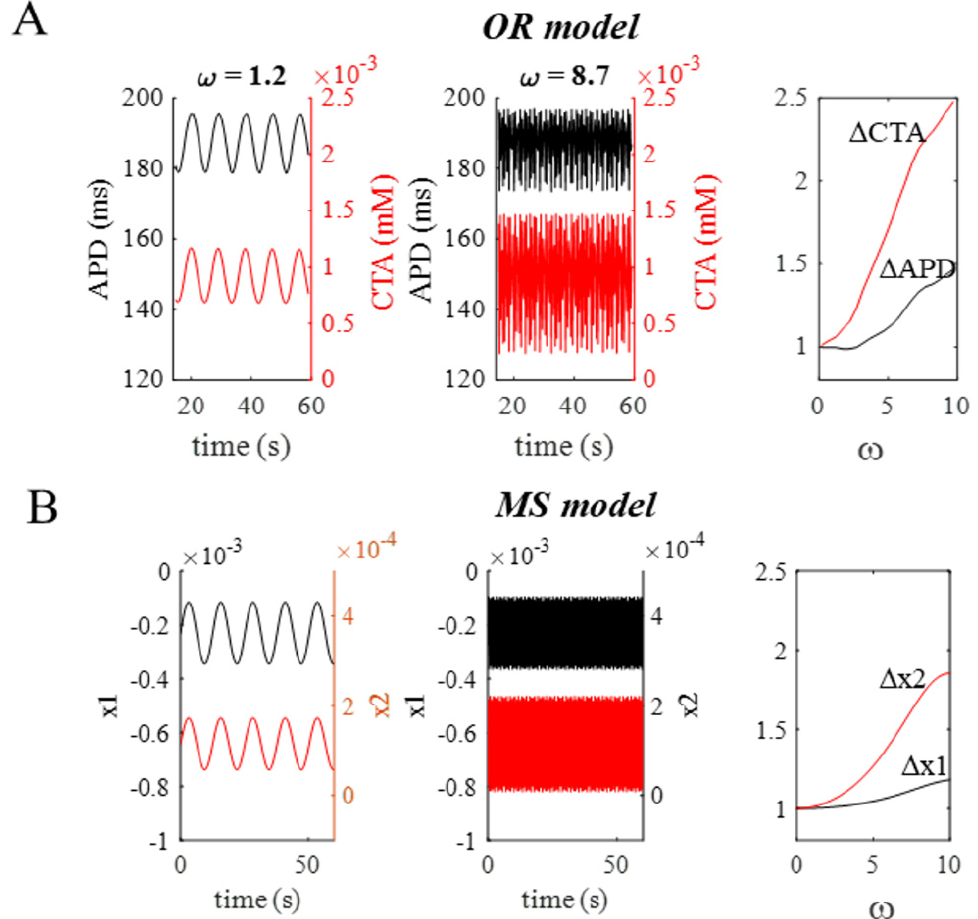
A detailed example of APD (black) and CTA (red) oscillations when the OR model is electrically paced with oscillatory CL (BCL = 300 ms, σ = 50 ms) at a low (first panel) and a high (second panel) ω values is reported in Figure 8A. ∆ APD and ∆ CTA are shown as functions of ω in the third panel, by assuming, for the sake of comparison, ∆ values = 1 at ω → 0. When ω increases, both the amplitudes of the APD and CTA oscillations increase as well (from 17.5 to 22.5 ms the former, and from 0.5 × 10 − 3 to 1.2 × 10 − 3 mM the latter), while their average values do not change (190 ms and MS model, with parameters of Table 1 except for a greater k 1 value of 795. The MS model with these parameters, which will be kept for the rest of the study, retains the features described in the previous section.